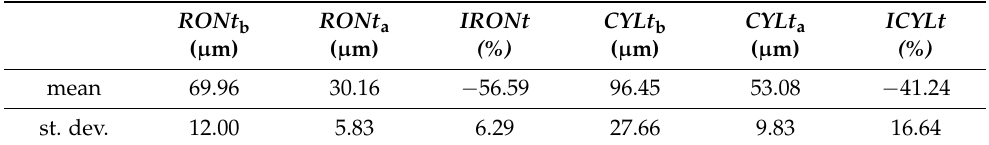
Table 3. Mean values and standard deviations of RONt and CYLt data before and after burnishing, and of improvement